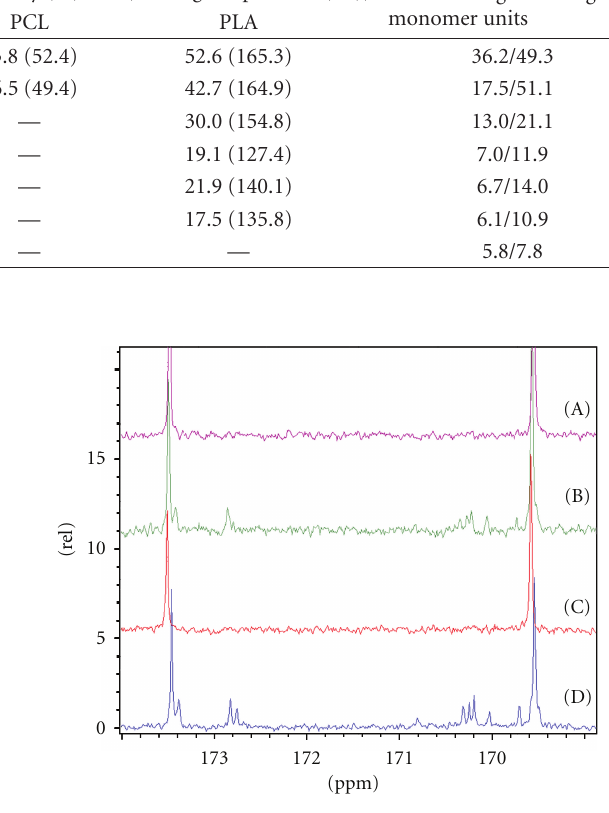
Table 1: Characteristics of triblock copolymers PCL-PLA-PCL synthesised with the use of di ff erent protective substances. N